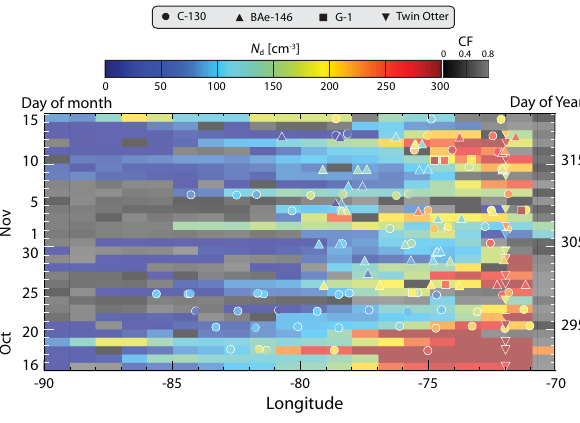
Fig. 10. Comparison of 20 ◦ S cloud leg-mean cloud droplet concen- tration N d , shown as shaded circles (C130) and triangles (BAe146), with daily MODIS-derived cloud droplet concentration along 20 ◦ S averaged on a 1 ◦ × 1 ◦ grid (color-shaded rectangles). Grey shades indicate cloud fraction (CF) in regions of broken cloud in which MODIS cannot reliably estimate N d